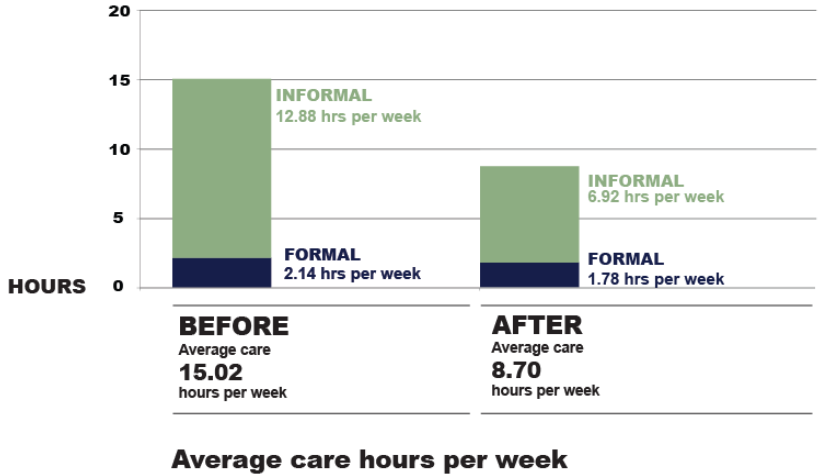
Figure 2. Analysis of care hours before and after home modifications.